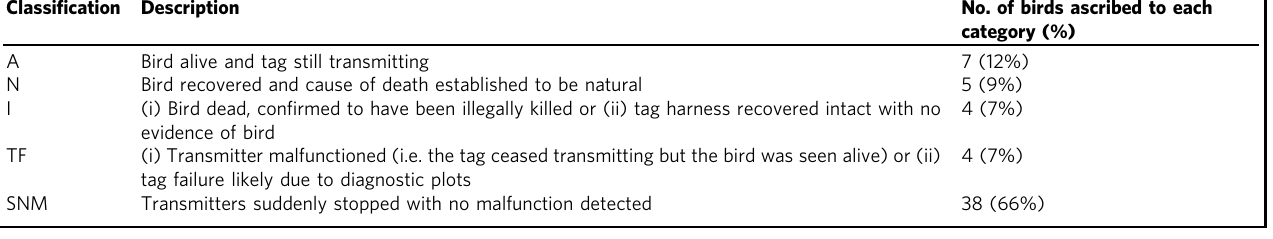
Table 1 Summary of fate classi fi cations from 58 satellite-tracked hen harriers Classi fi cation Description